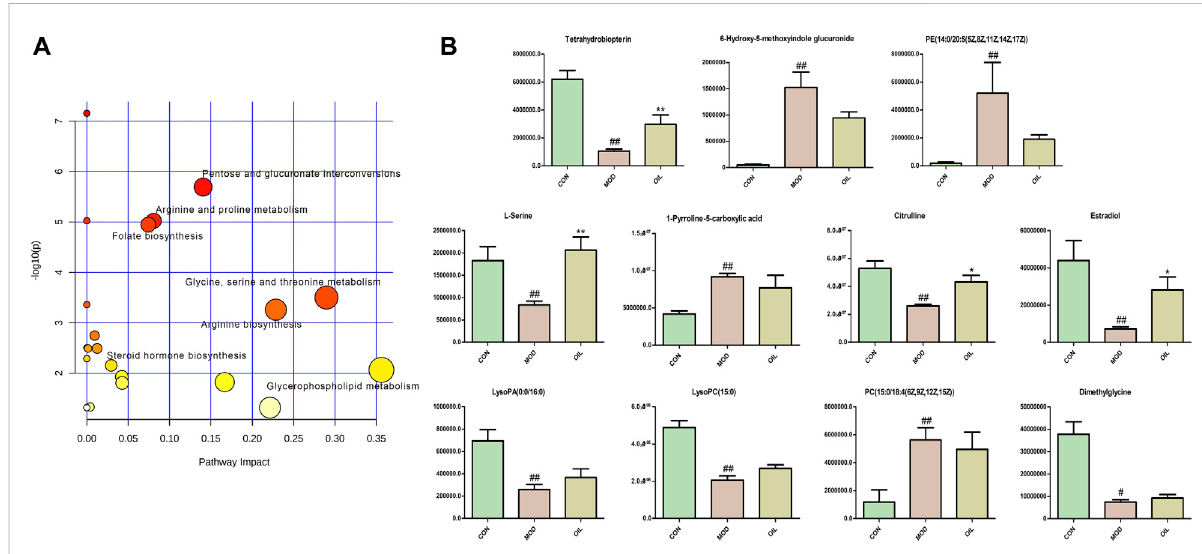
FIGURE 5 Metabolic pathway analysis of crucial biomarkers (A) . The size and colour of each circle indicate the pathway impact value and p -value respectively. Statistical signi fi cance of the 11 potential biomarkers were calculated using ANOVA after administration of A. mongolica oil (B) . * p < 0.05 and ** p < 0.01 compared to the model control group. # p < 0.05 and ## p < 0.01 compared to the control group.